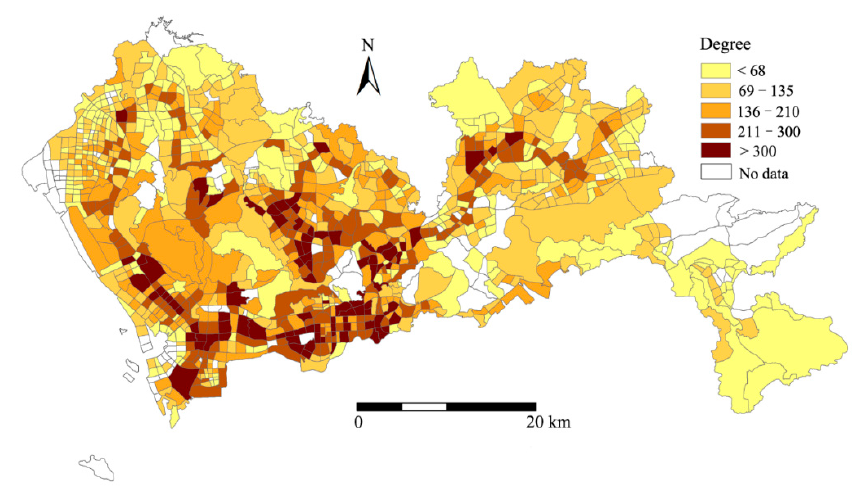
Figure 3. Spatial degree distribution. ISPRS Int. J. Geo-Inf. 2019 , 8 , x FOR PEER REVIEW